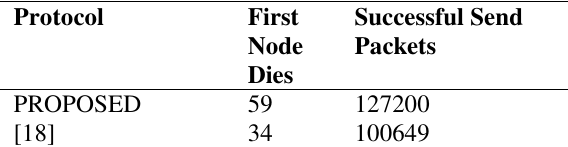
A comparison with other